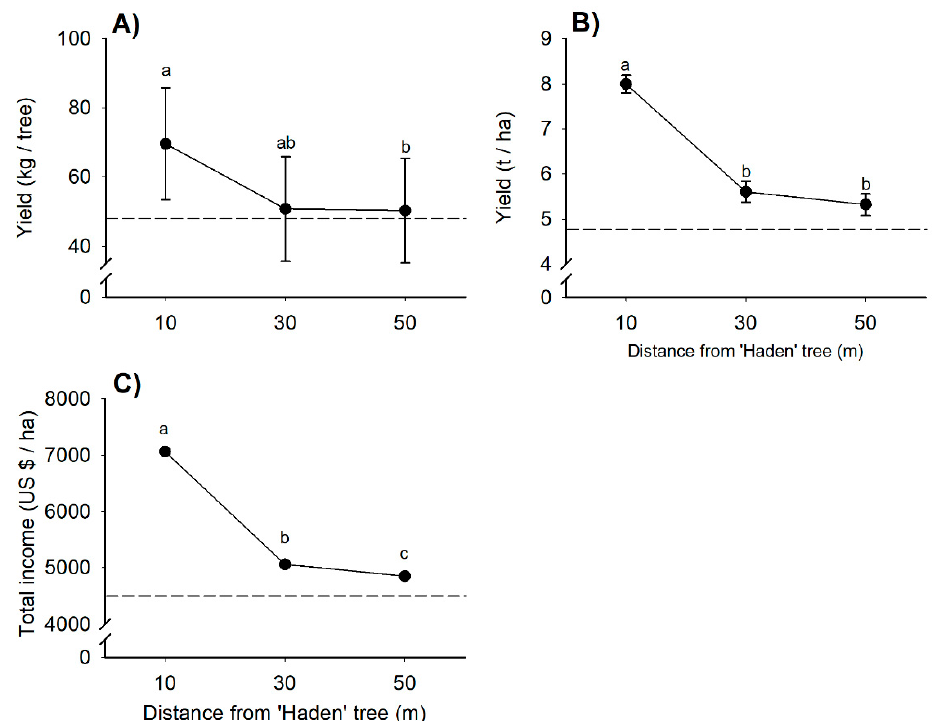
Figure 5. Estimated yield and economic income (mean ± SE) of trees and orchards of ‘Ataulfo’ in three plantation designs considering different distances from ‘Haden’ trees. ( A ) ‘Ataulfo’ yield per tree, ( B ) Total yield per hectare, and ( C ) Total economic income per hectare. In B and C, yield and economic income, respectively, of both ‘Ataulfo’ and ‘Haden’ were considered. Dotted lines indicate the average values of ‘Ataulfo’ orchards without ‘Haden’ individuals. Different letters indicate statistical differences among plantation scenarios, according to GLMM and Tukey’s test ( p < 0.05).